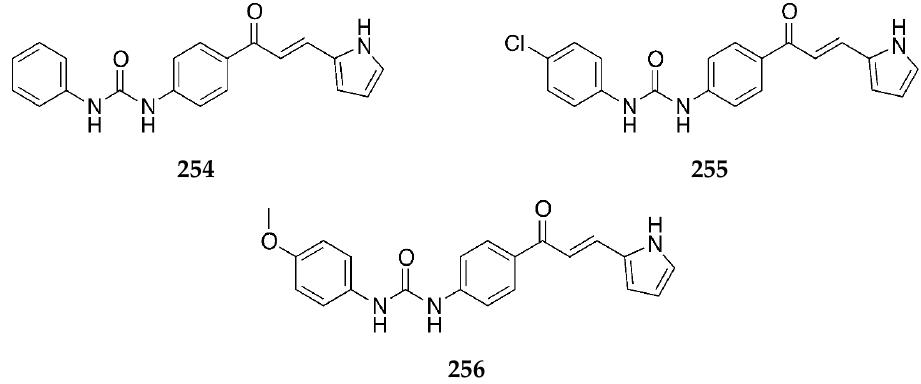
Figure 71. Chemical structure and side chains of N -acyl-4-aminochalcone derivatives with substitution on ring B.